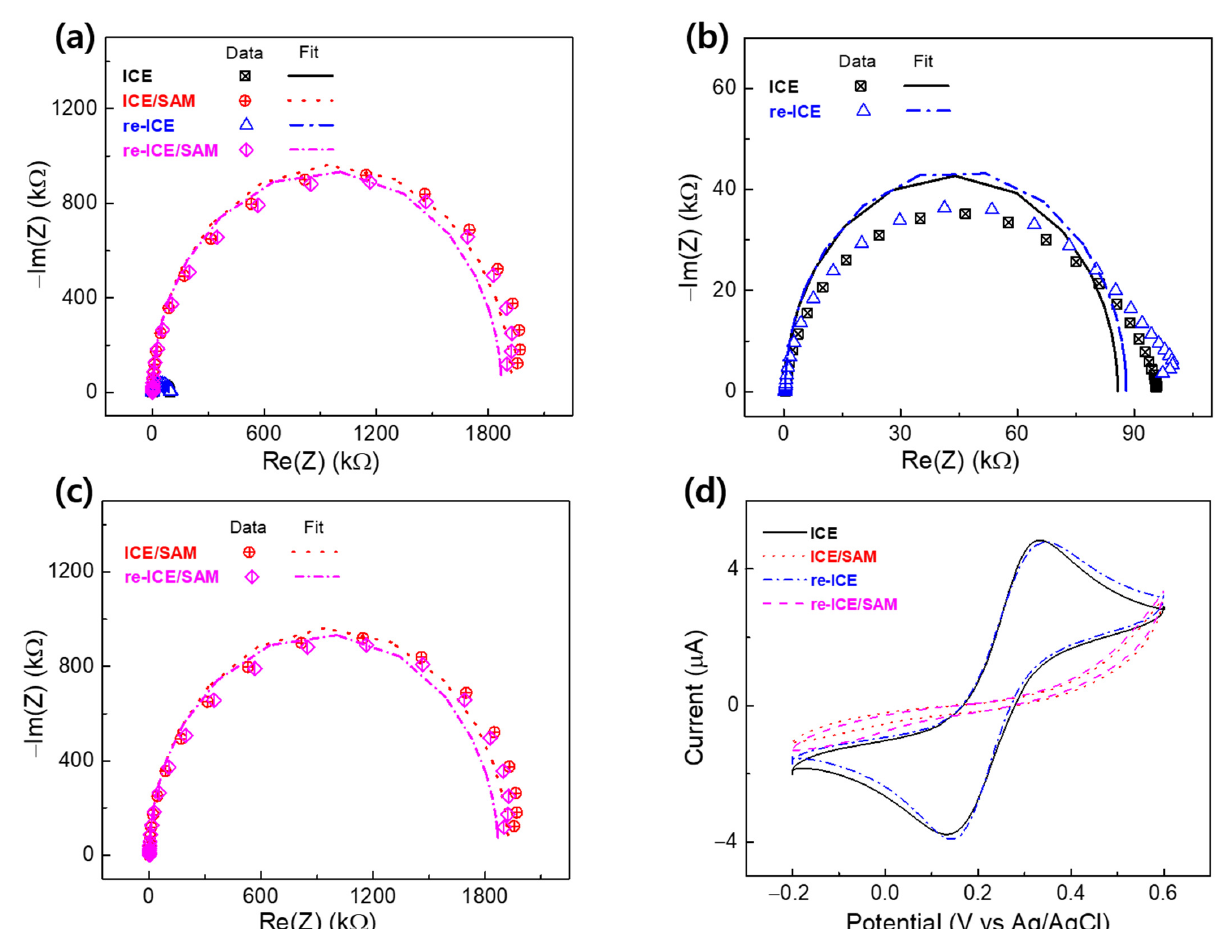
Figure 5. ( a – c ) EIS, expressed by Nyquist plots, and ( d ) the CV results of ICE, ICE/SAM, re ‐ ICE, re ‐